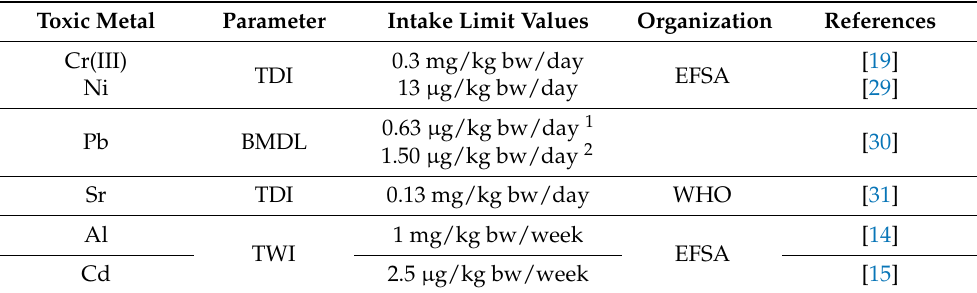
Table 4. Intake limit values of the toxic metals analyzed (Al, Cd, Cr, Pb, Ni, Sr).